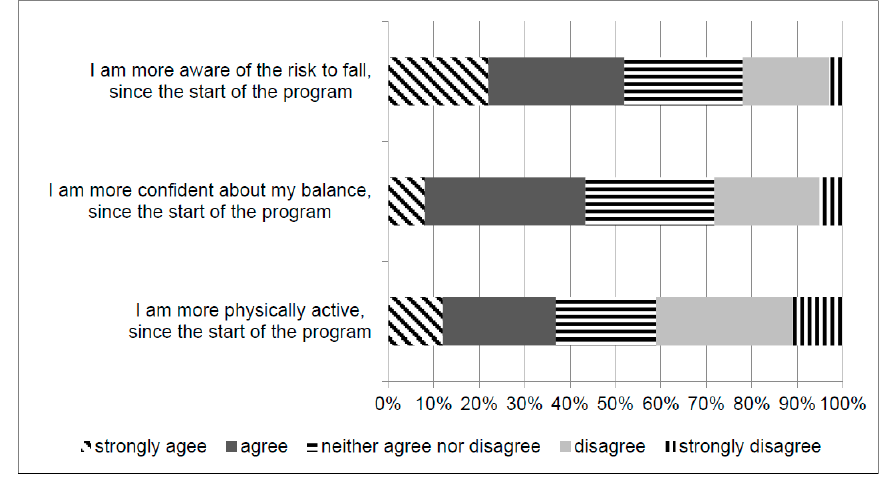
Figure 2. Program satisfaction of the participants after the twelve-week home-based exercise program.